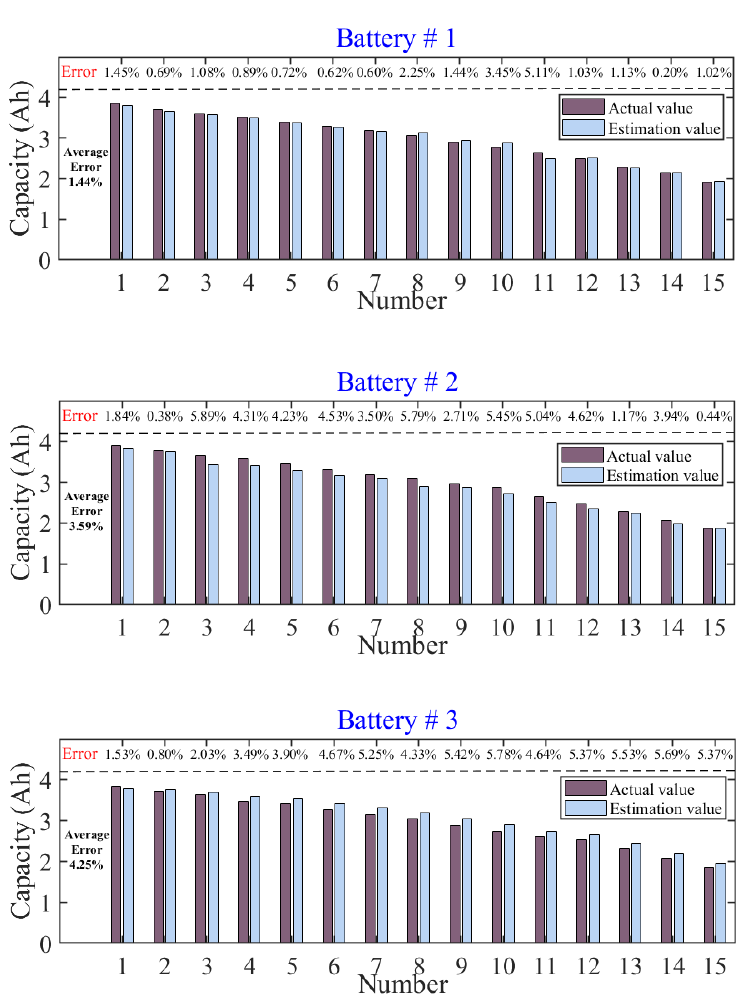
Figure 7. Estimation results of all tested batteries.